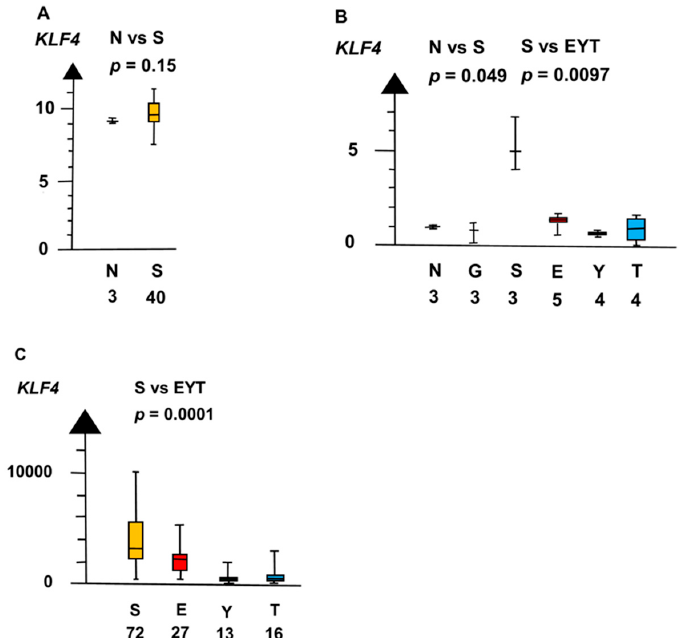
Figure 7. RNA expression of KLF4 in the three datasets ( A – C ) show that seminoma (S) had a high RNA expression and that germ cell neoplasia in situ (G), embryonal carcinoma (E), yolk sac tumor (Y), and teratoma (T) had a low RNA expression.